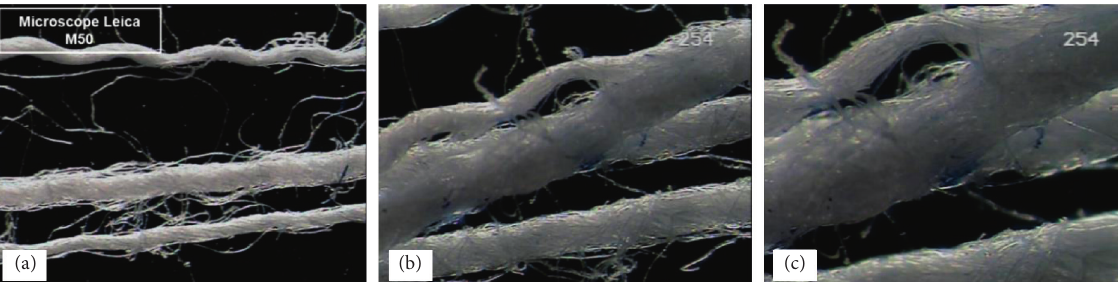
Figure 6: Images of the woven fabric cotton-PES assembled yarn. (a) 51X on-screen magnification. (b) 80X on-screen magnification. (c) 128X on-screen magnification.